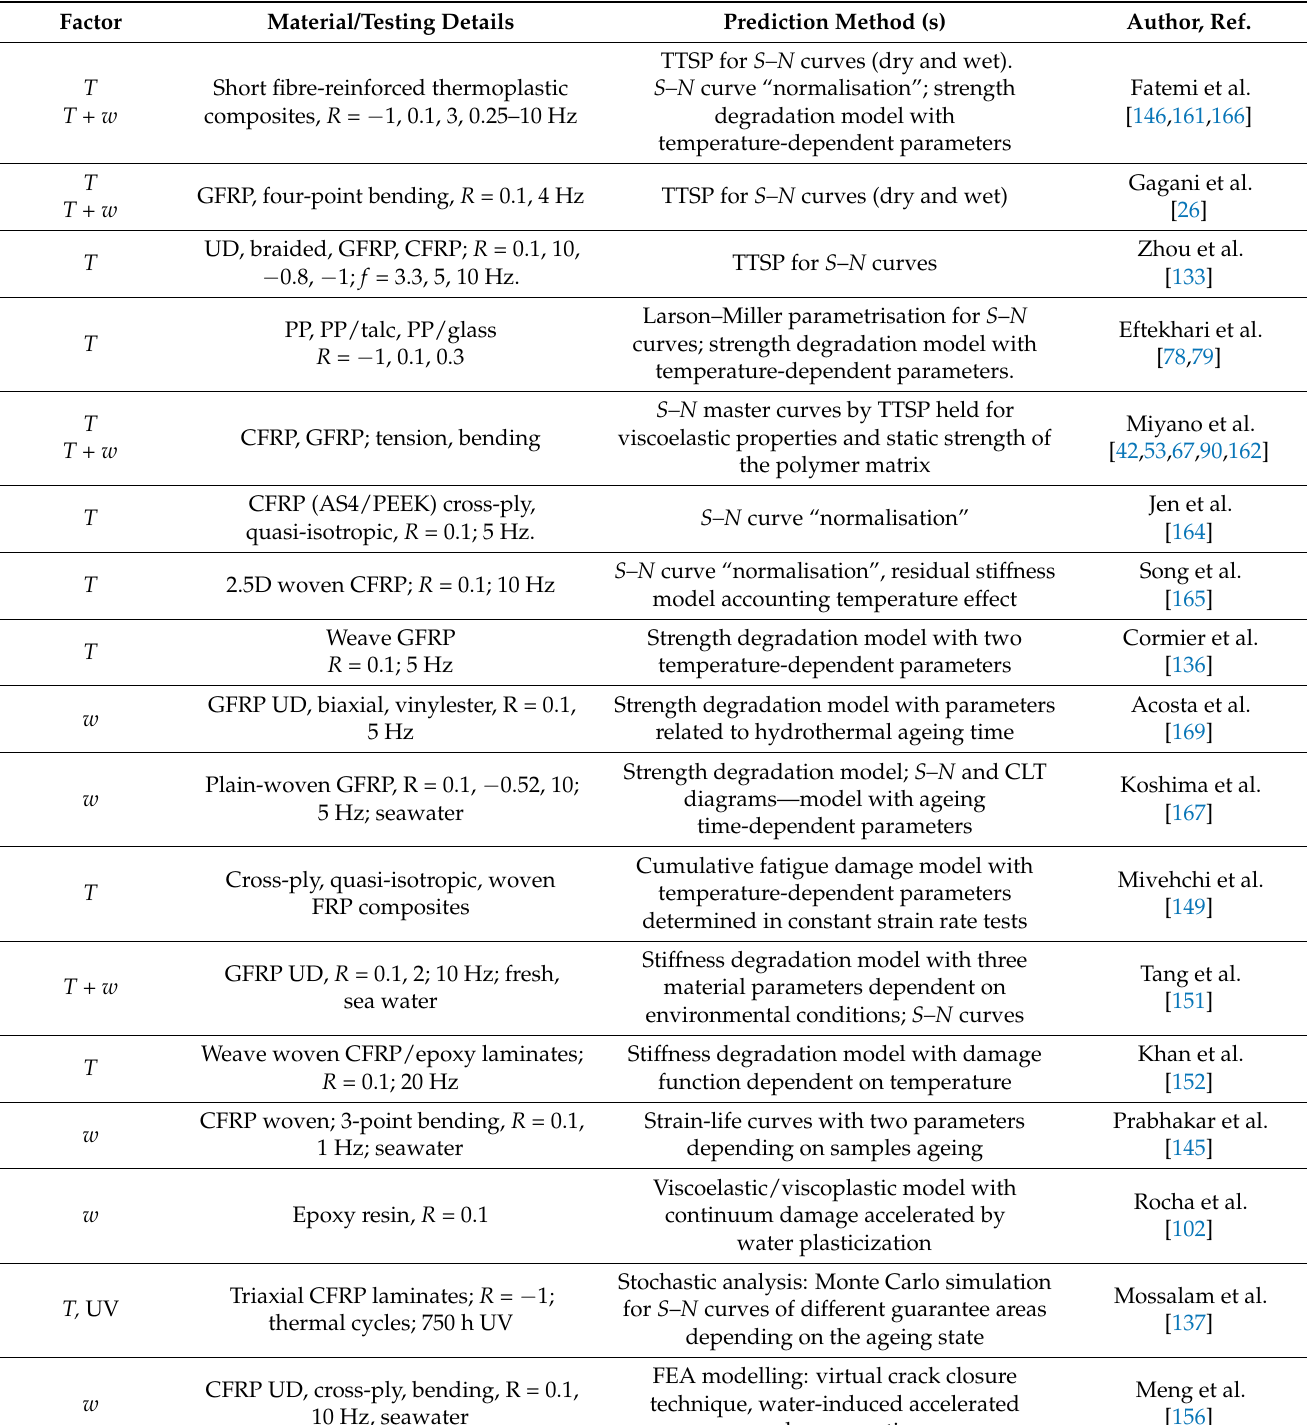
Table 2. A condensed list of recent works modelling fatigue under environmental impacts ( T and w are associated with temperature and water effects,